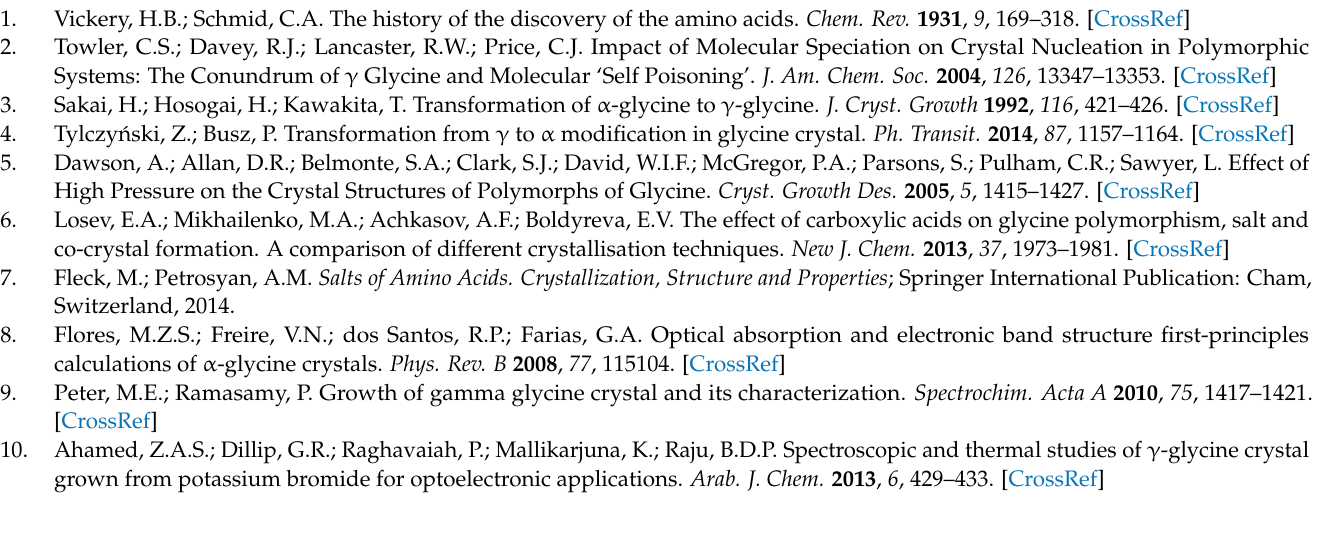
Figure S5: Rietveld fit results for α -Gly:CA (90:10). Table S5: Low frequency intermolecular